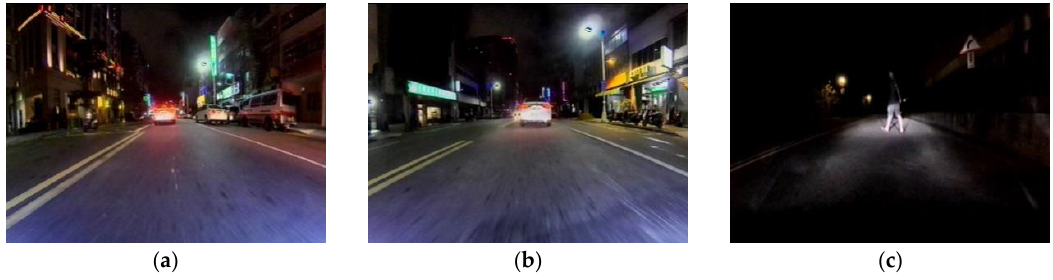
Figure 12. Daytime scenarios: ( a ) sunlight, ( b ) pavement puddle, and ( c ) shadow.